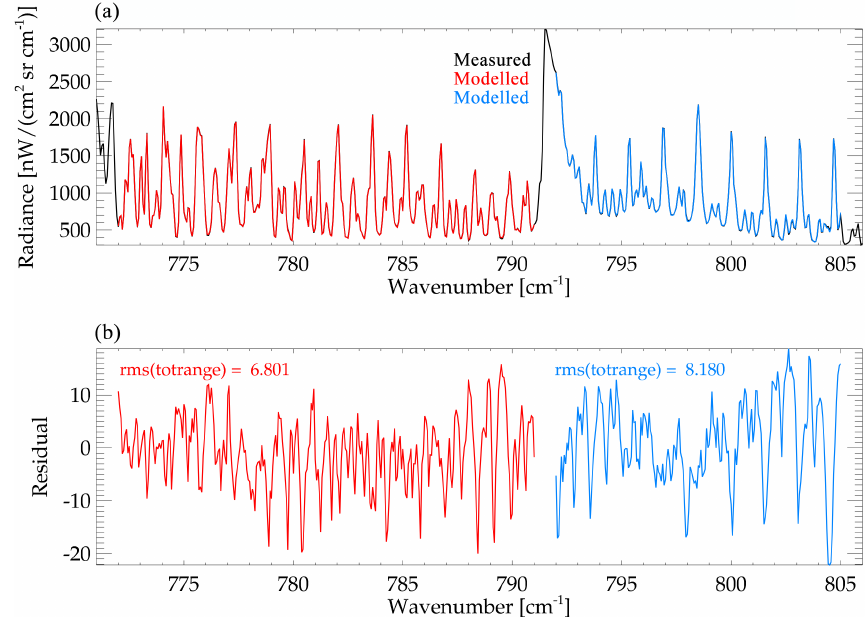
Figure 2. Exemplary spectra of MIPAS CCl 4 at 11.5km during the RR period (July 2008): (a) spectra; (b) residuals.